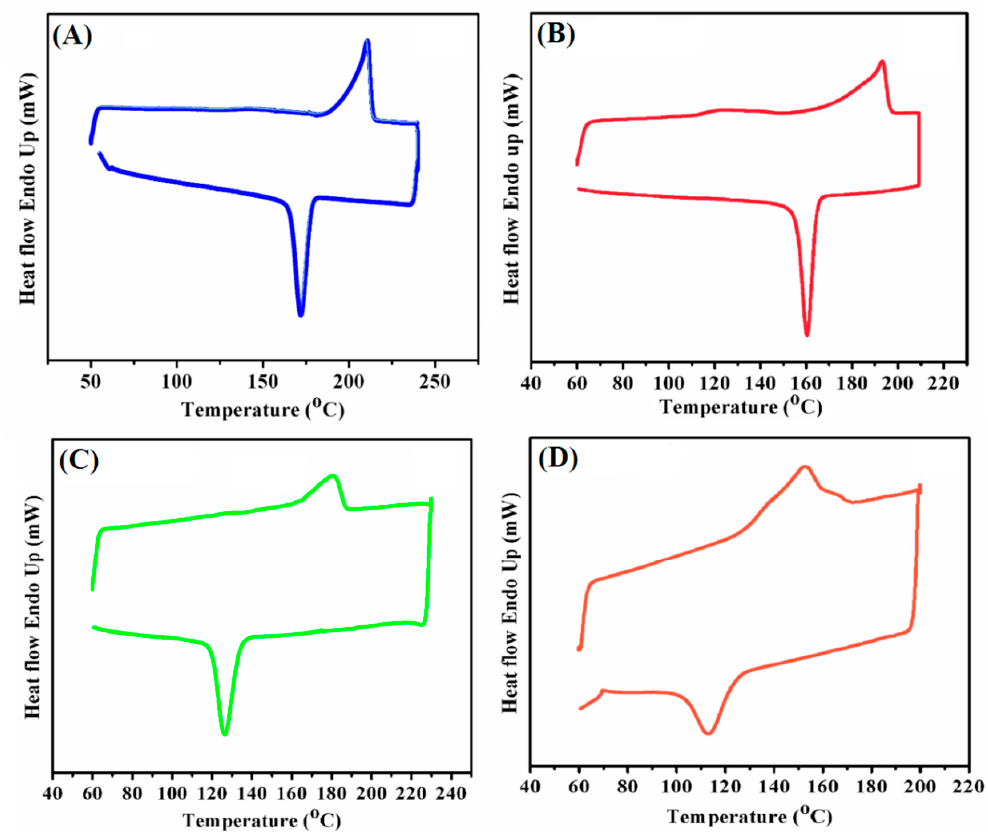
Figure 11. DSC analysis of ( A ) PA6, ( B ) PA6-PABT/SA10, ( C ) PA6-BABT/SA20, and ( D ) PA6- BABT/SA30 copolyamides. SA30